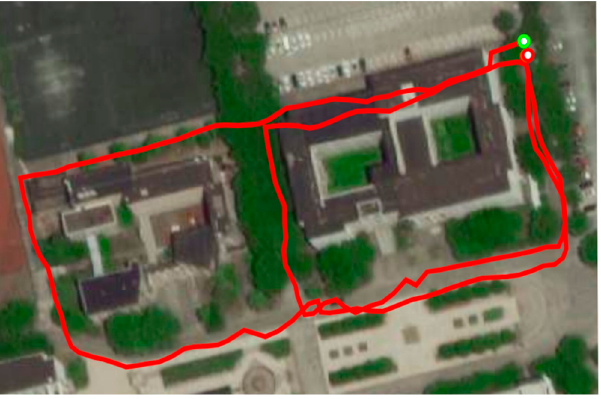
Figure 12. The ground truth of 8-shaped path formed around Jingwen Library and Wenhui Build- ing.